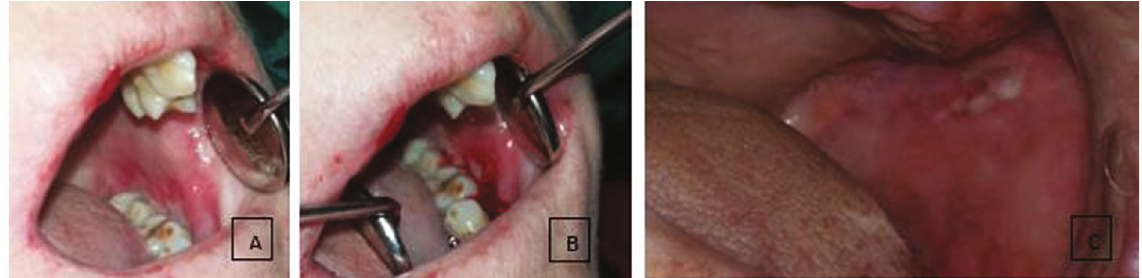
Figure 2: (a) The image showing atrophy of the lip, painful ulcers of the buccal mucosa, and keratosis of the lips. (b) It was clinically detected that the oral epidermal tissue easily separated from the connective tissue. (c) Leukoplakia-like lesions were observed in the buccal